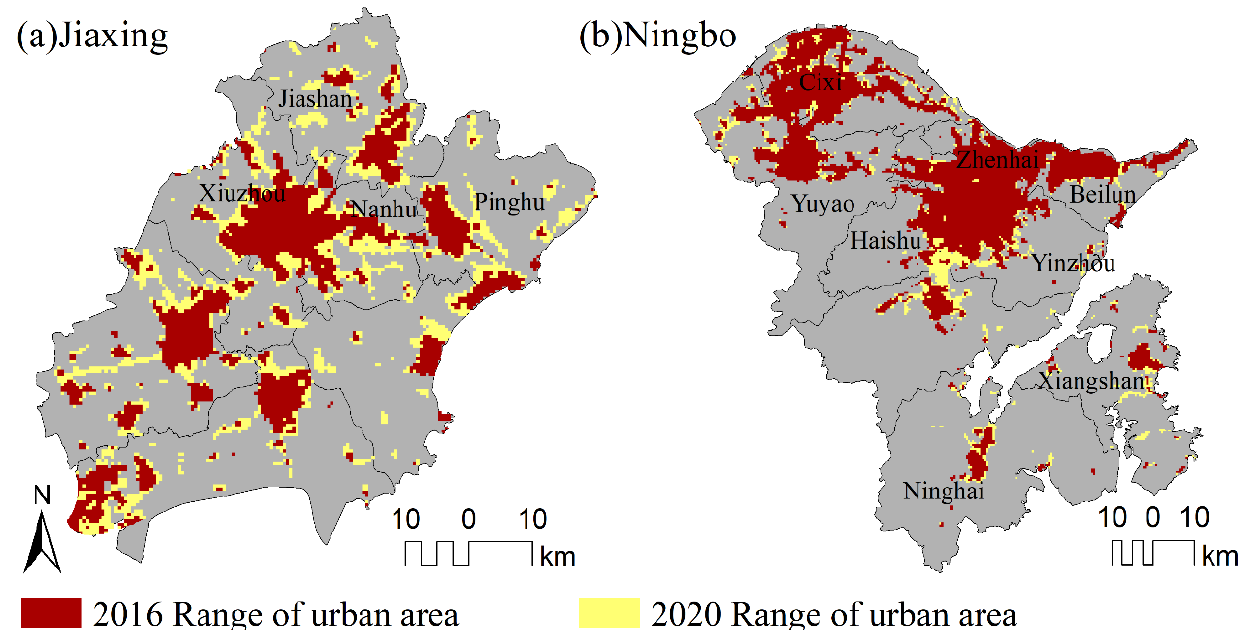
Figure 8. Nighttime light growth trends in Jiaxing and Ningbo from 2016 to 2020.